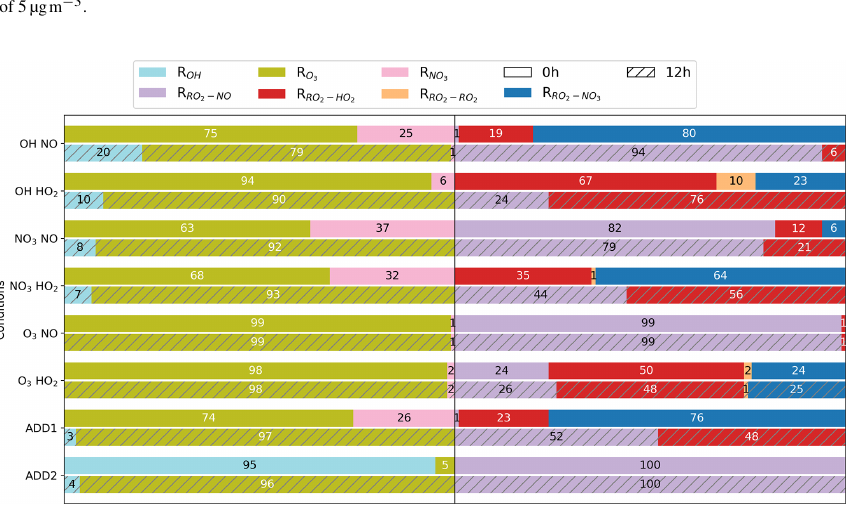
Figure 2. A bar plot showing the occupancy of seven reaction ratios in the BCARY initiation reactions and RO 2 reactions, under the training conditions at midnight (00:00GMT + 1, top bar) and noon (12:00GMT + 1, bottom bar with hatching). From left to right, six ratios